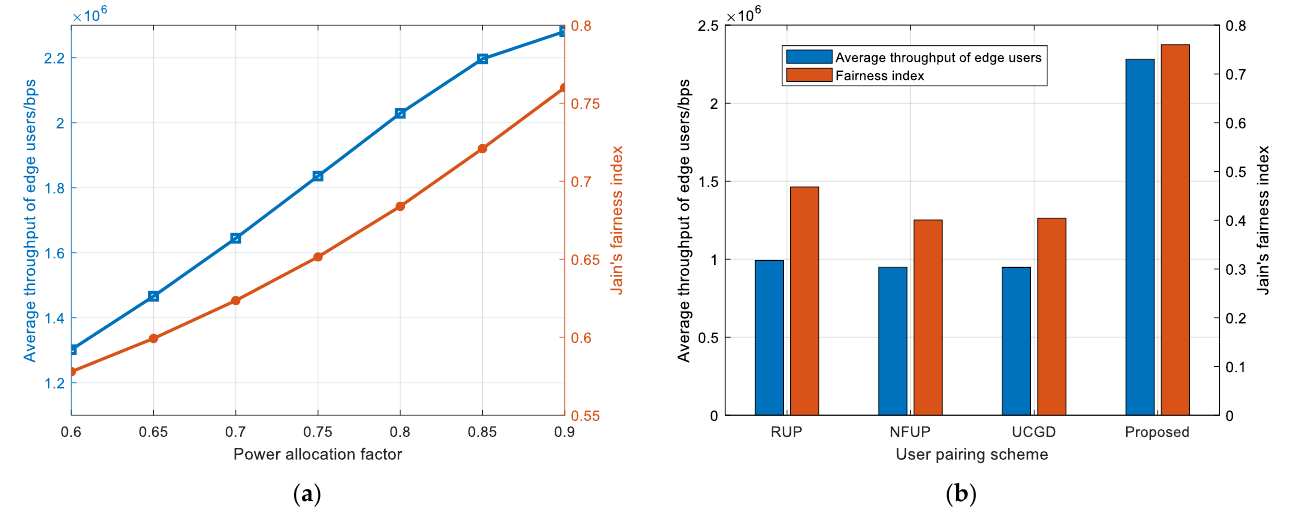
Figure 3. Throughput performances of edge users and fairness index: ( a ) under proposed user pairing scheme with different power allocation factors; ( b ) under different user pairing schemes ( 0 . 9 α = ).